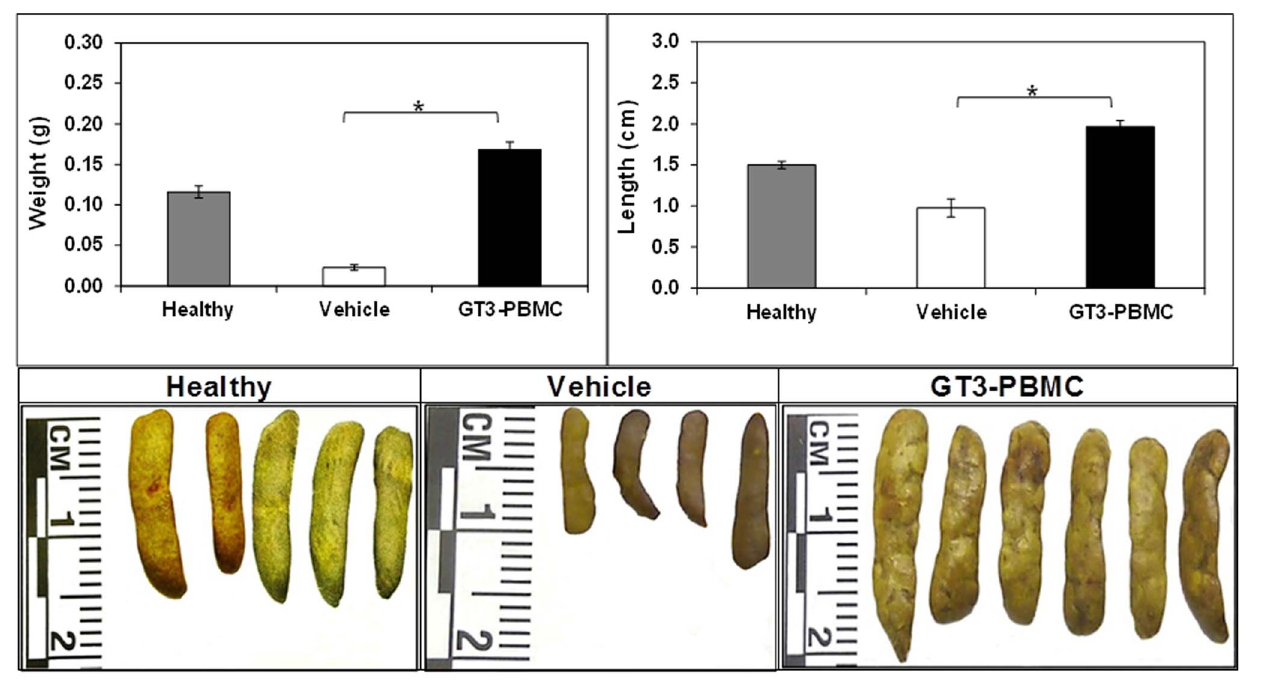
Figure 5. Effects of TS administration on colony forming unit-spleen in CD2F1 mice. GT3 mobilized PBMC were administered to CD2F1 mice iv 24 h after irradiation. Spleens were harvested 12 days after irradiation (11 Gy at 0.6